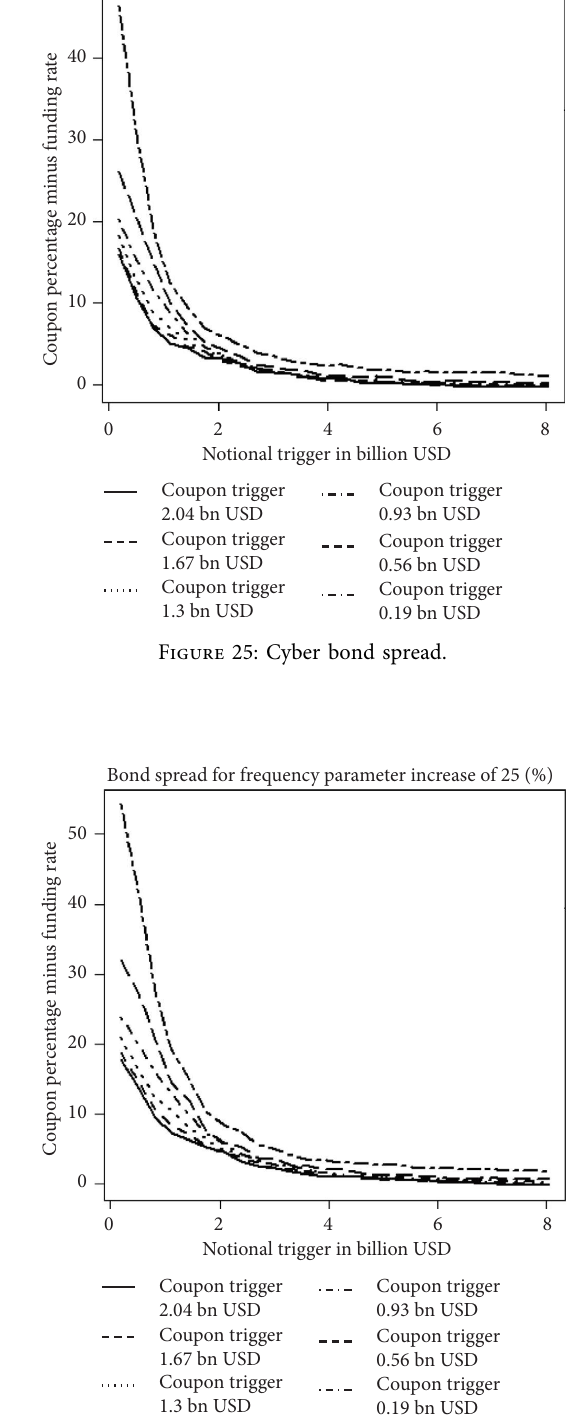
Figure 24: Cyber bond par yield curve for loss severity parameter μ increase of 5%.